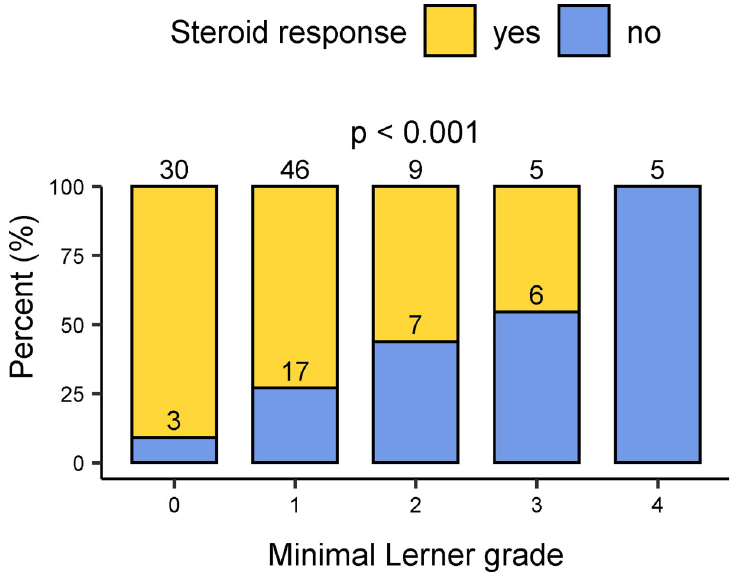
Fig 5. Comparison between the response to steroid therapy and the minimum histologic Lerner grade of a biopsy series. Numbers in bar charts indicate the count of cases for each group (only patients having received steroid therapy are included (n =